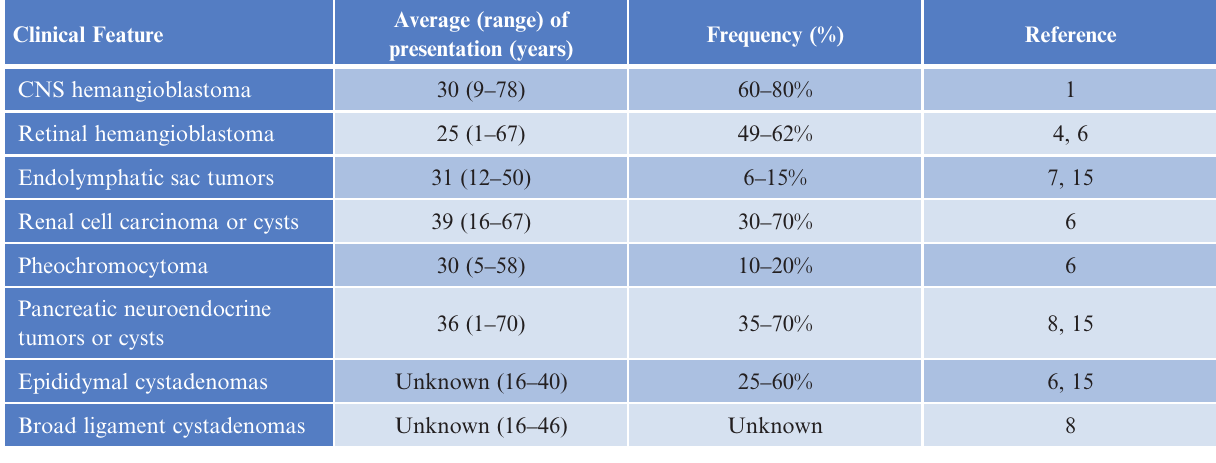
Table 3. Frequency of lesions and average age range of presentation in VHL patients Clinical